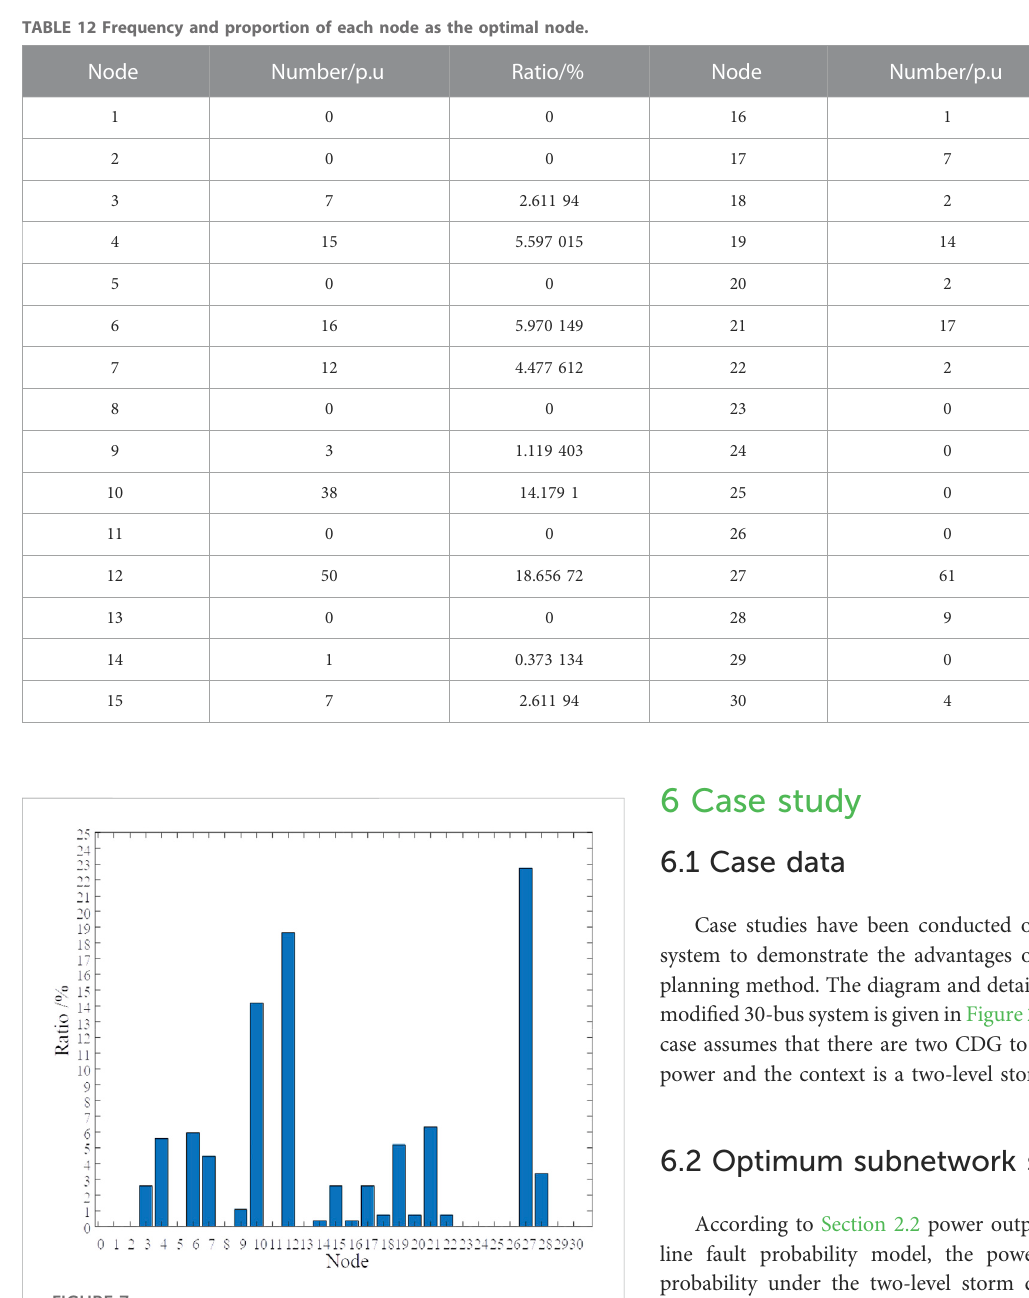
FIGURE 7 Recovered load